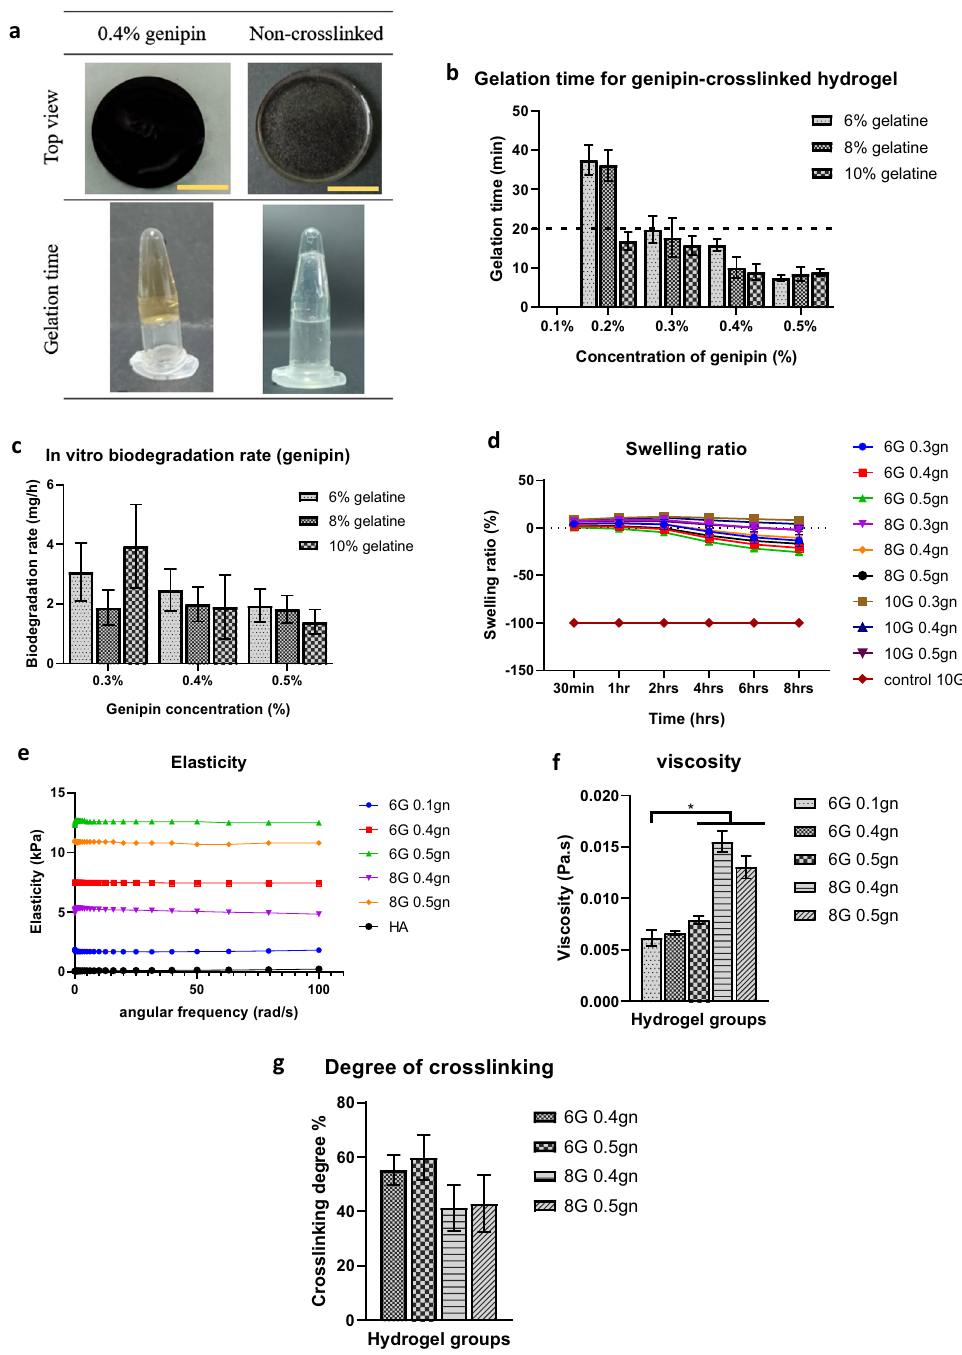
Figure 1. Optimization of the genipin crosslinked gelatin hydrogels (N = 3, n = 9, * p < 0.05). ( a ) Physical appearance of the 6% gelatin hydrogels. Each yellow scale bar represents 1 cm. ( b ) Gelation time of genipin- crosslinked gelatin hydrogels. ( c ) Biodegradation rate of genipin-crosslinked gelatin hydrogels. ( d ) Swelling ratio of genipin-crosslinked gelatin hydrogels. ( e ) Elasticity of the genipin-crosslinked gelatin hydrogels. Commercial hyaluronic acid was included as a comparison in this experiment. ( f ) Viscosity of the genipin-crosslinked gelatin hydrogels. ( g ) Crosslinking degree of genipin-crosslinked gelatin